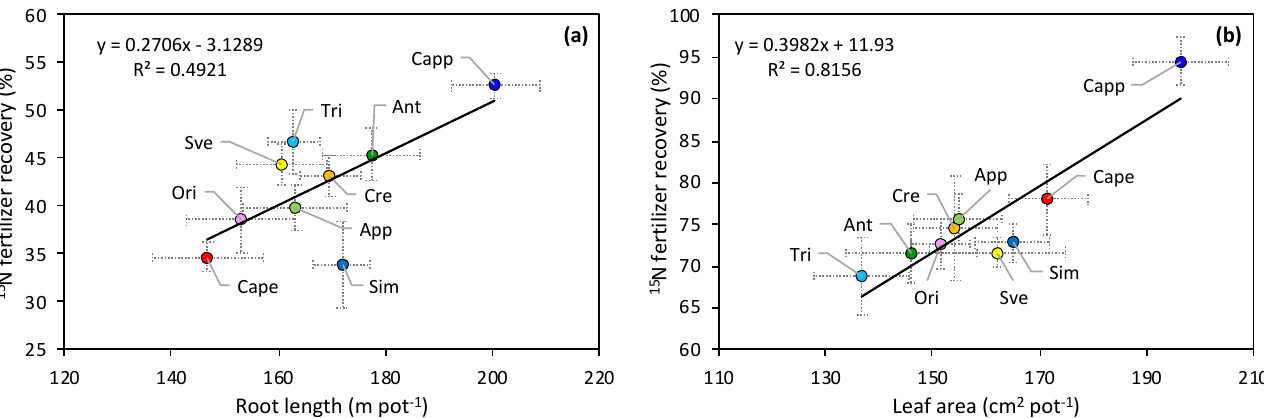
Figure 4. Relationships between root length (measured 90 days after emergence; Time 1) and the percentage of 15 N recovered from the fertilizer (% 15 Nrec) 7 days after fertilization ( a ) and leaf area (measured at 90 days after emergence; Time 1) and the percentage of 15 N recovered from the fertilizer (% 15 Nrec) 35 days after fertilization ( b ).